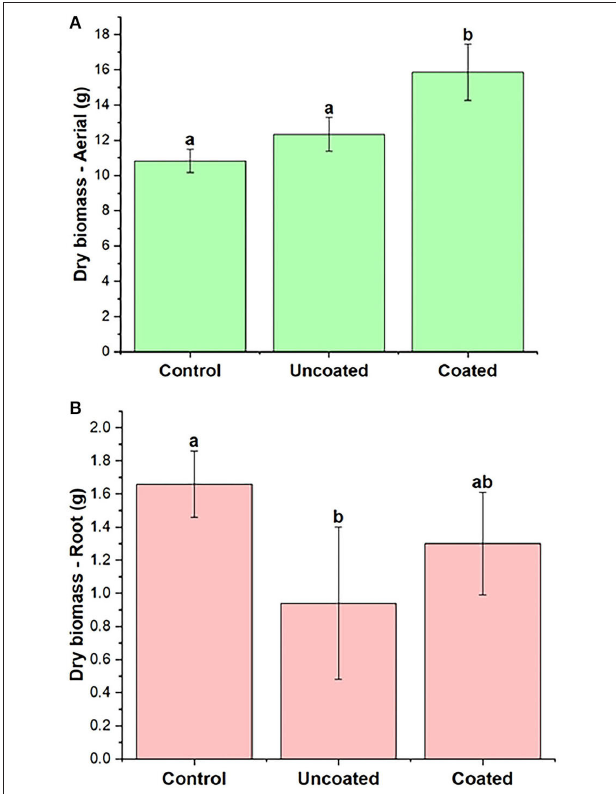
FIGURE 4 | Spring rye (A) aerial (B) root dry biomass, representing control, uncoated, and coated treatments. Lowercase letters (a–e) indicate significant differences between treatments ( p <